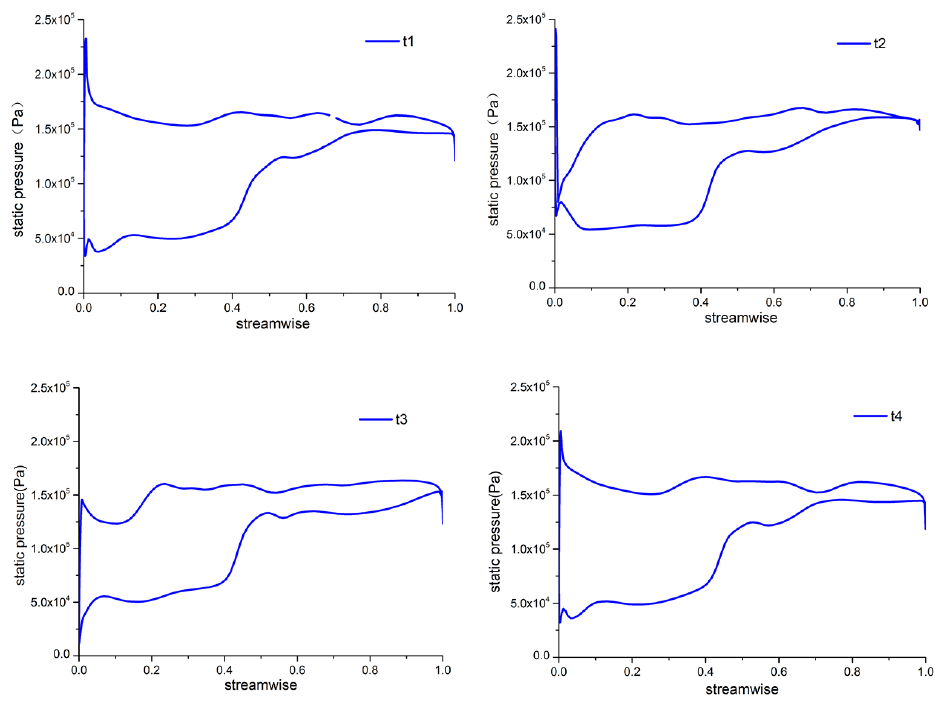
Figure 12. The tip load curves at 99% span in an unsteady period for the solid wall